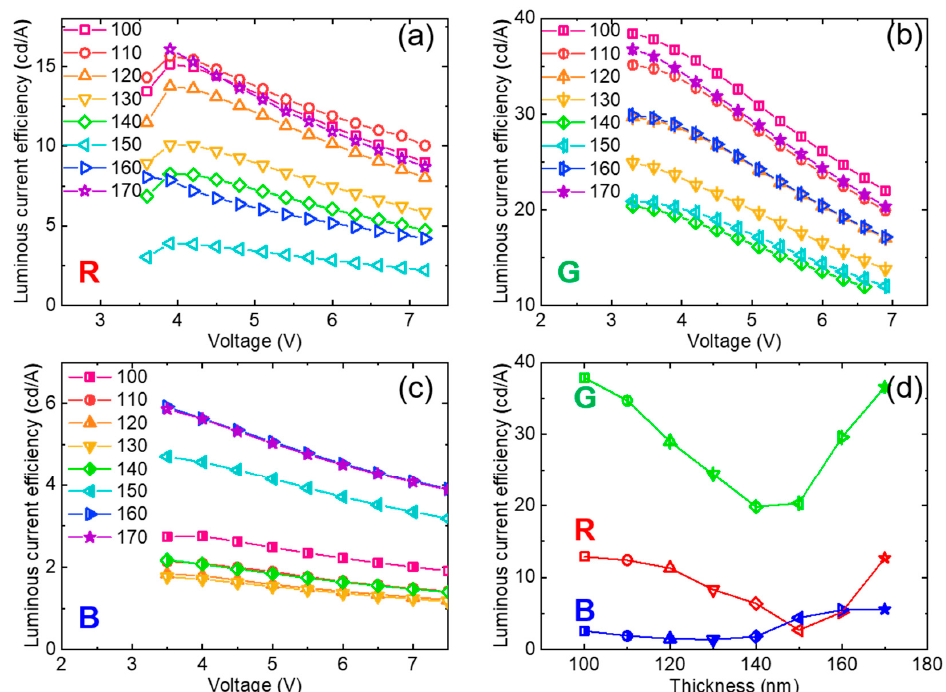
Figure 7. Luminous current efficiency of ( a ) R, ( b ) G, and ( c ) B devices with different voltages and ( d ) R, G, B devices at approximately 1000 cd/m 2 depending on OSL thicknesses. Table 1. Performance of the R, G, and B devices with micro-cavity structure embedded cathodes depending on OSL thicknesses.